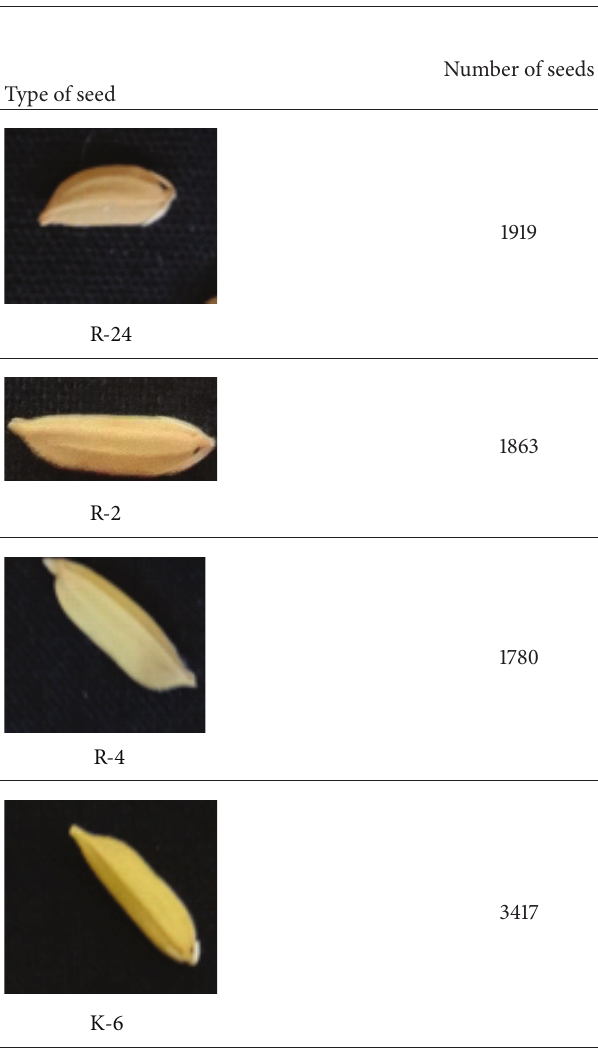
Table 1: Type of different variety of grains and Number of seeds.